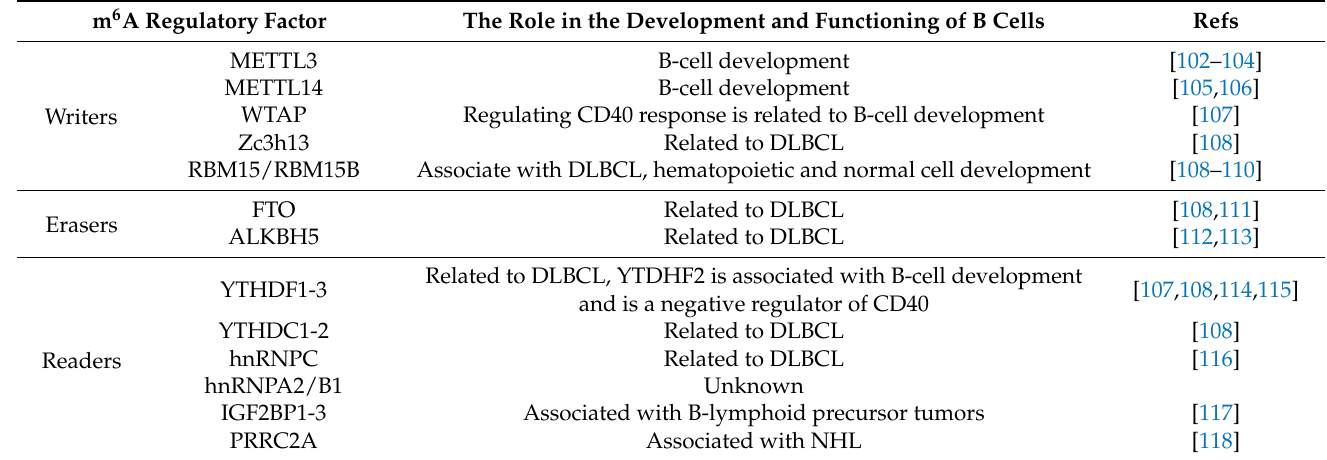
Table 1. m 6 A regulatory factors and roles in the development and functioning of B cells. The Role in the Development and Functioning of B